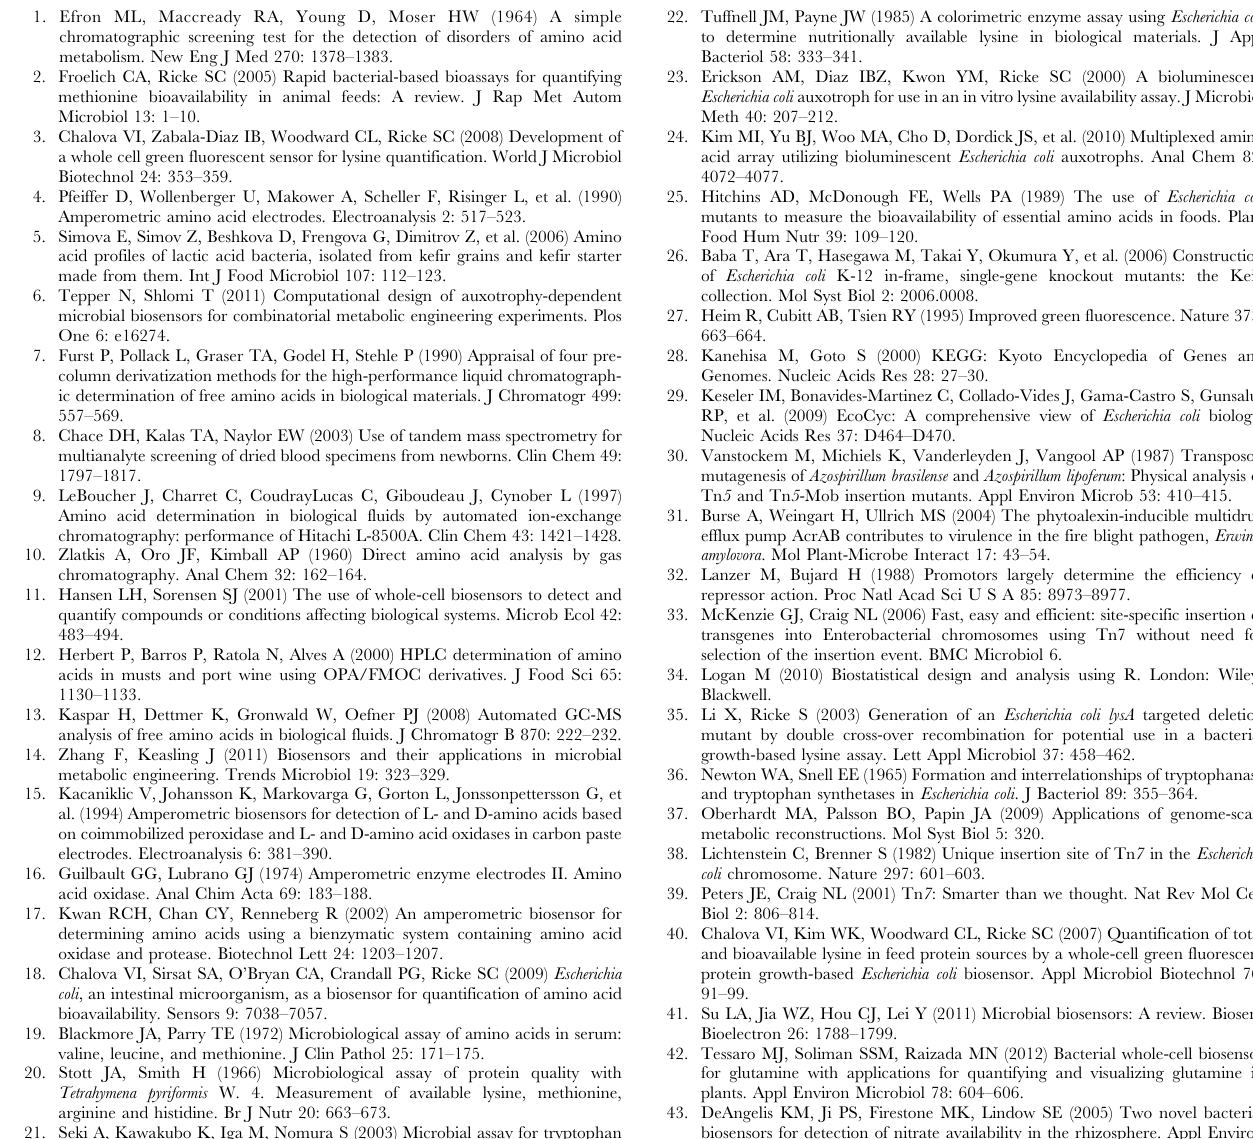
Figure S1 Time-dependent growth of the eleven biosen- sors in the presence of the focal amino acid. Biosensor growth was determined as culture turbidity (OD 600 nm ) in minimal medium supplemented with the focal amino acid (3 mM). Mean values (lines) of eight replicates (squares) are given. (TIF) Figure S2 Development of GFP-fluorescence of the tryptophan biosensor cultivated in various concentra- tions of tryptophan. Mean fluorescence emission of eight replicates is given as relative fluorescence units (RFU) after 12 h (triangles), 18 h (circles), and 24 h (squares) of growth.